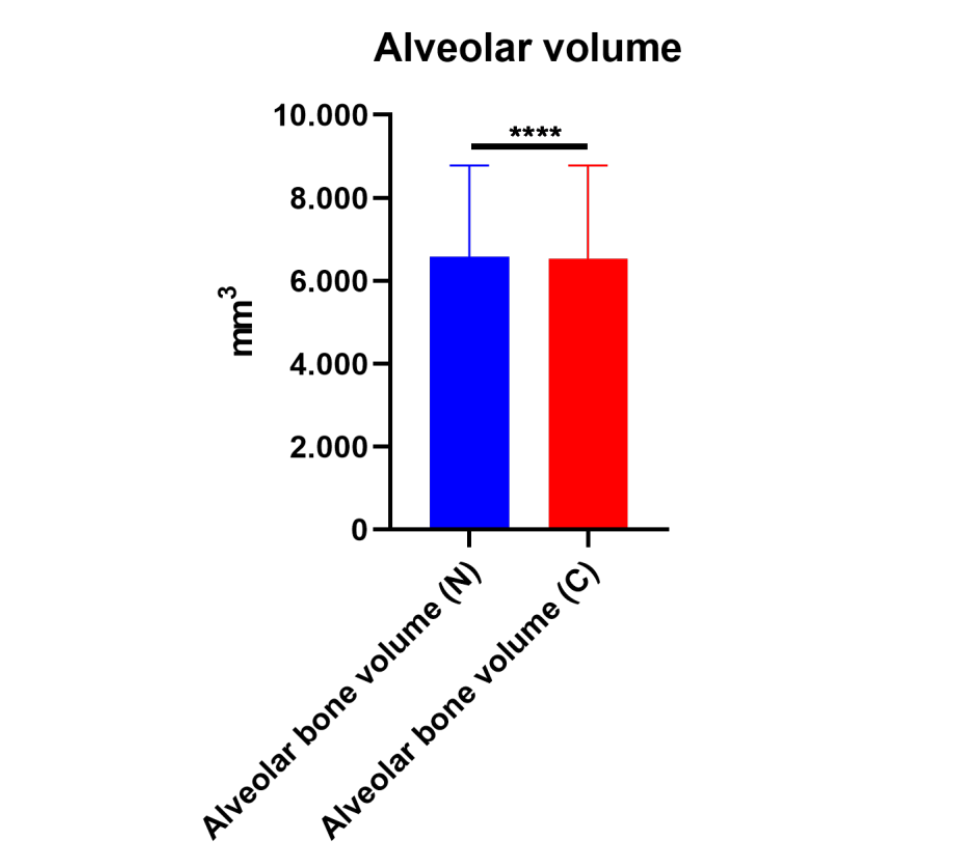
Figure 3. Differences in bony height, thickness, and paranasal hypoplasia between cleft and normal sides. **** p < 0.0001.